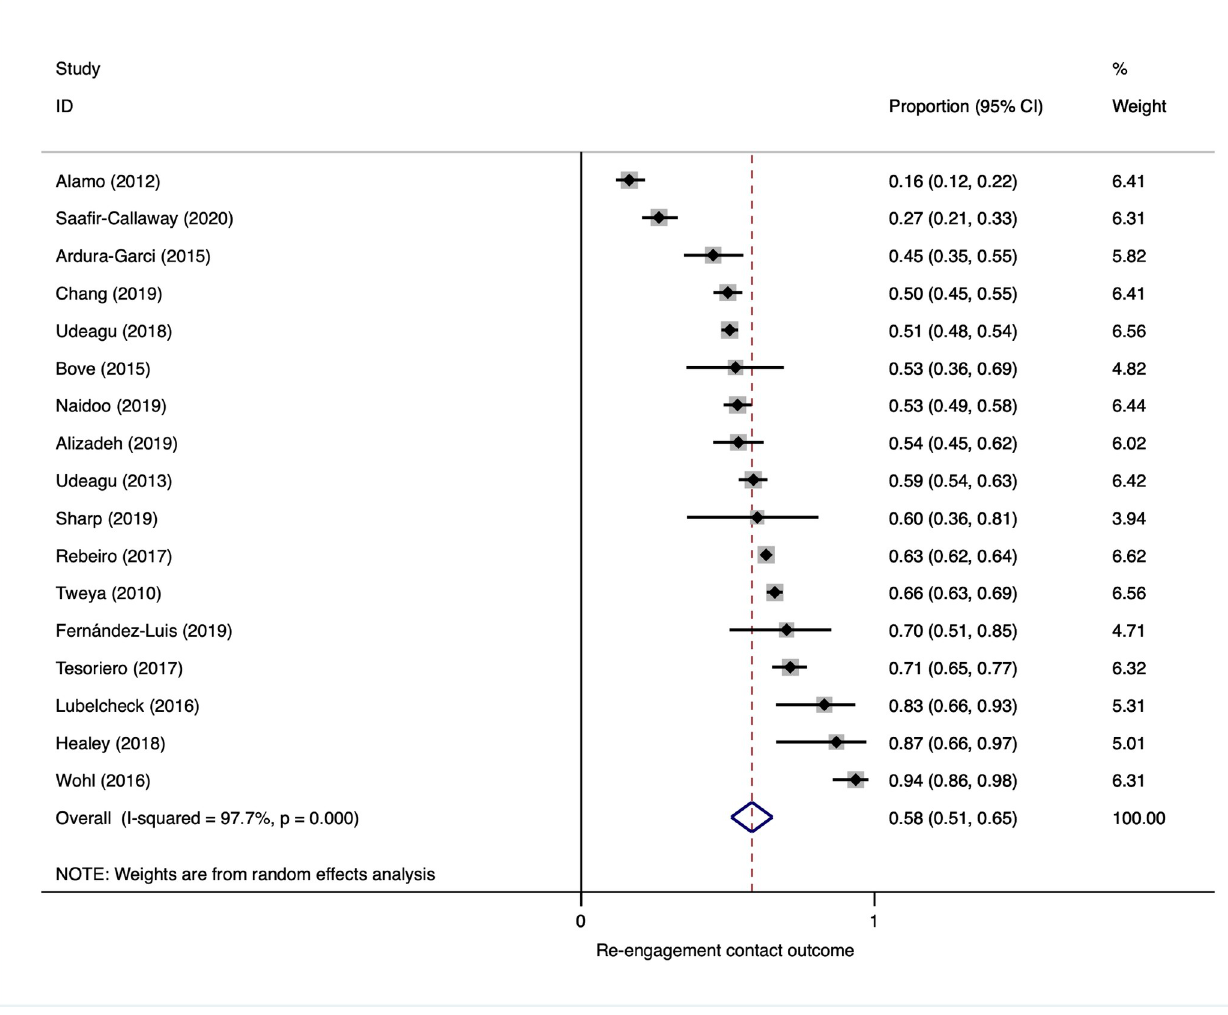
Fig 6. Reengagement contact outcome: proportion found alive and out of care who returned to care (in reengagement intervention study arms).